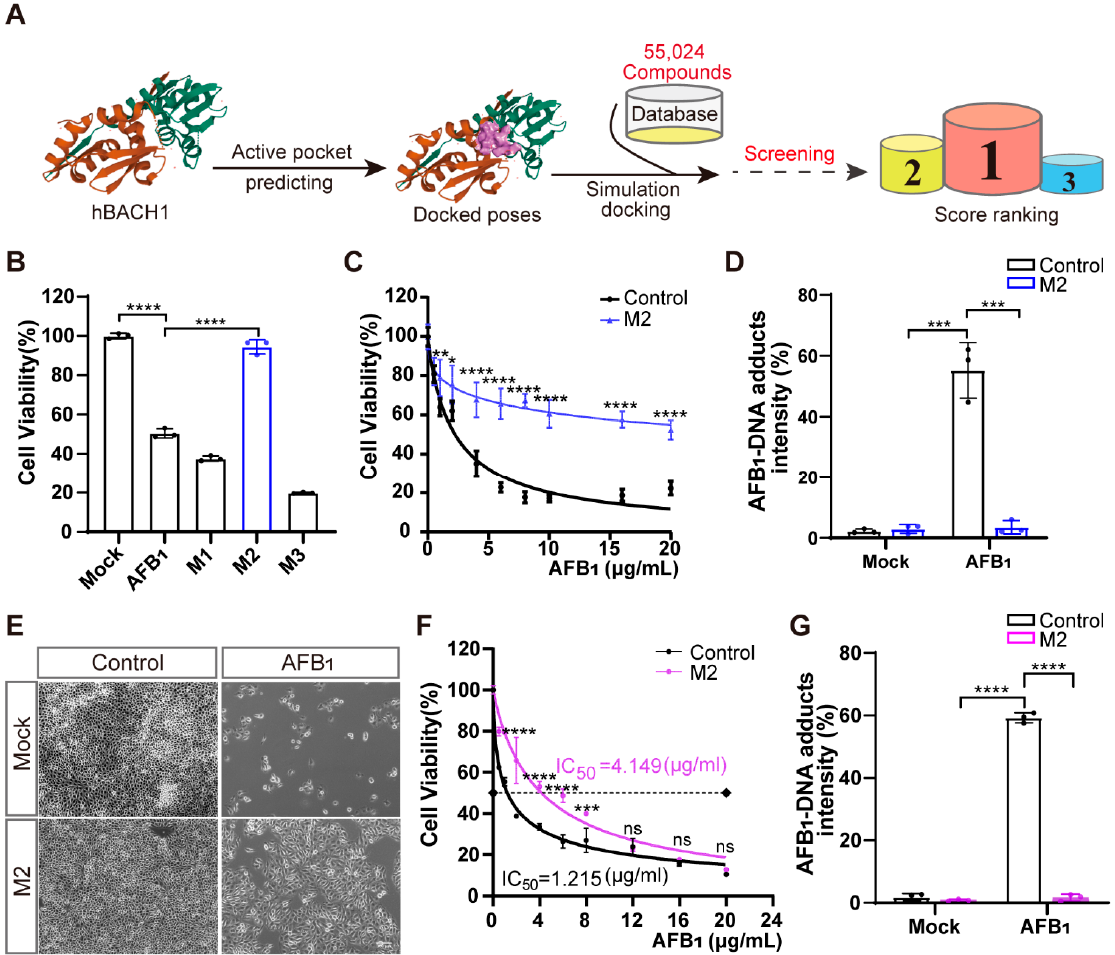
Figure 4. Treatment with inhibitor M2 leads to the highest resistance to aflatoxin B 1 in vitro. ( A ) Workflow of the structure-based virtual screening to identify inhibitors targeting BACH1. ( B ) Validation of the top three inhibitors (M1, M2, and M3) in Huh7 cells by CCK-8 assays. ( C ) Comparation of Huh7 tolerance to different AFB 1 concentrations with and without M2 treatment. ( D ) The relative fluorescence intensity of AFB 1 -DNA adducts in Huh7 cells with and without M2 treatment. ( E ) Representative light microscopy images of AFB 1 -treated PK-15 cells with or without M2 treatment. Scale bar, 100 µ m. ( F ) The IC 50 assays for AFB 1 in PK-15 cells with and without M2 treatment determined with CCK-8 assays. ( G ) The relative fluorescence intensity of AFB 1 -DNA adducts in PK-15 cells with and without M2 treatment. * p < 0.05, ** p < 0.01, *** p < 0.001, **** p < 0.0001, ns, not significant. p values were determined with two-tailed Student’s t -tests. AFB 1 , aflatoxin B 1 ; M1, 1-Piperazineethanol, 4-phenyl- α -[[(3,4,5- trimethoxyphenyl)methoxy]methyl]; M2, 1-Piperazineethanol, α